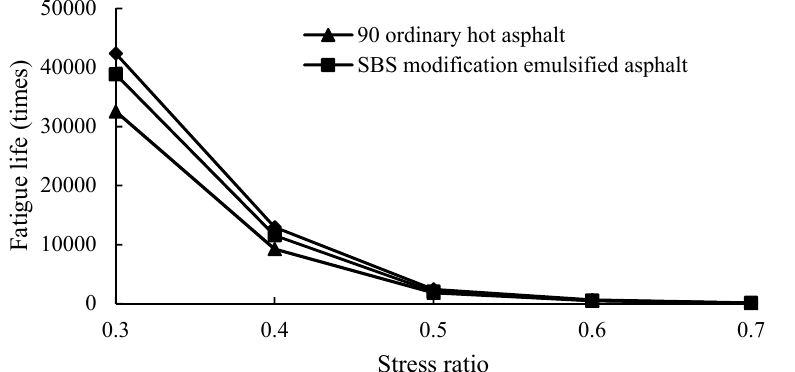
Figure 10. Variation in fatigue life for different waterproof cohesive layer materials with different stress ratios (15 °C).